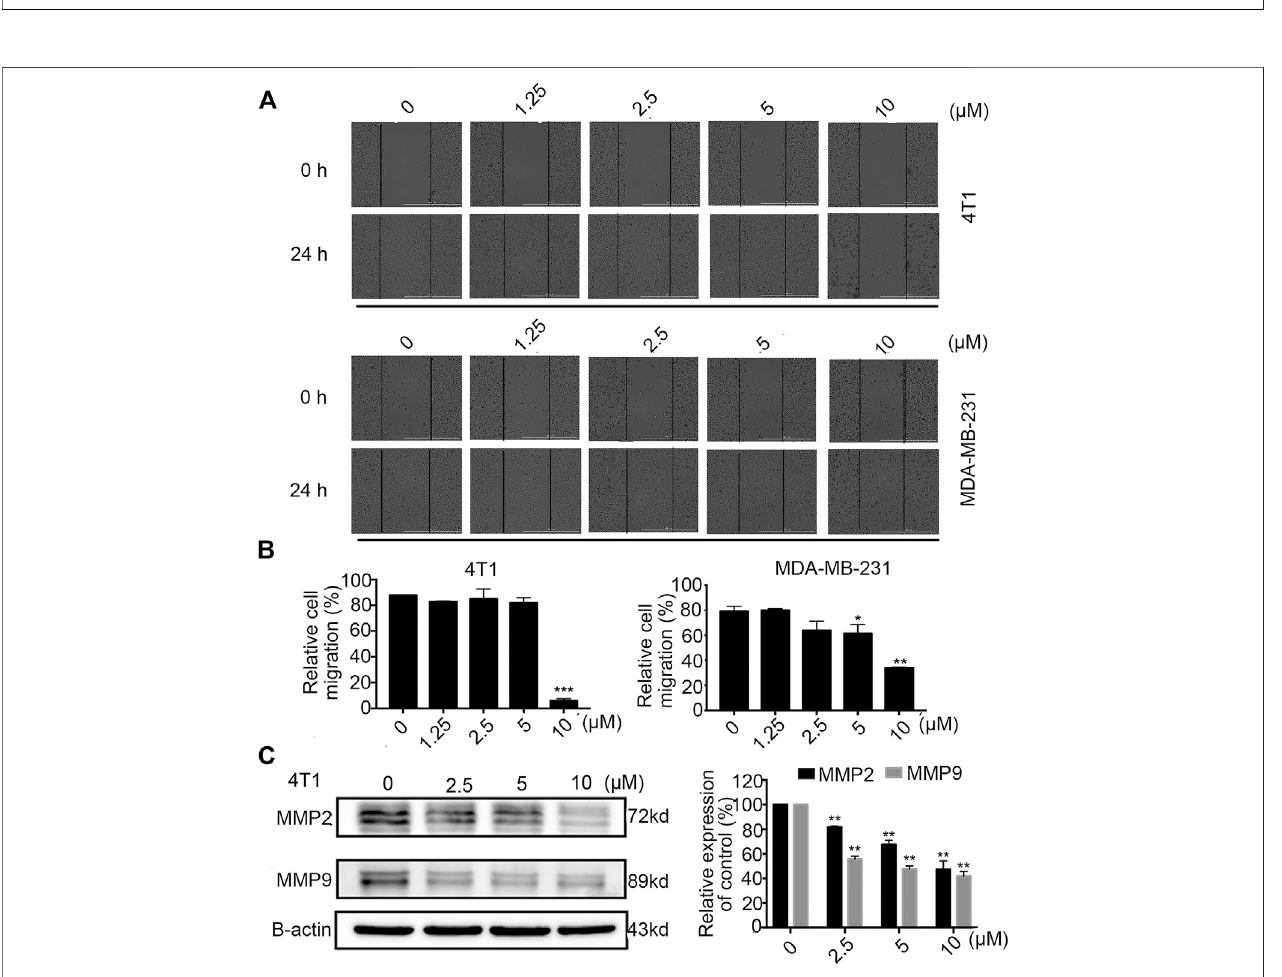
FIGURE 7 | Statmp-151 inhibited cell migration of 4T1 and MDA-MB-231 cells. (A) The images were taken after treating with Statmp-151 for 0 and 24 h with the lines indicating the area occupied by the initial scraping. (B) The migrated cells were quanti fi ed in a histogram. (C) The cells treated with Statmp-151 for 24 h were harvested, and the expression levels of MMP-2 and MMP-9 were measured by western blotting and quanti fi ed.